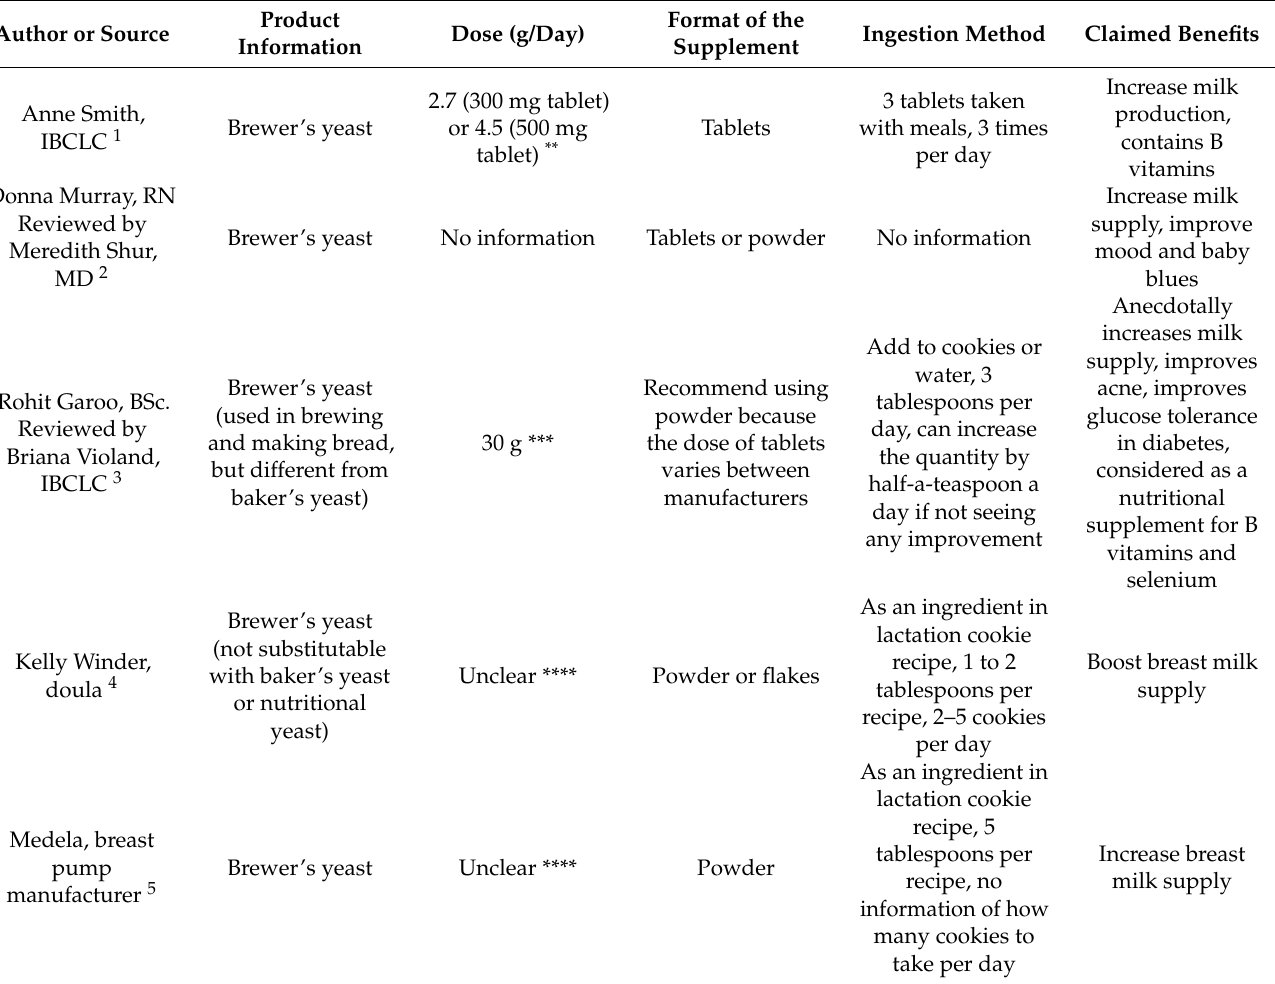
Table 3. A selection of information found on the internet about taking Saccharomyces cerevisiae yeast-based supplements (SCYS) to increase breast milk production